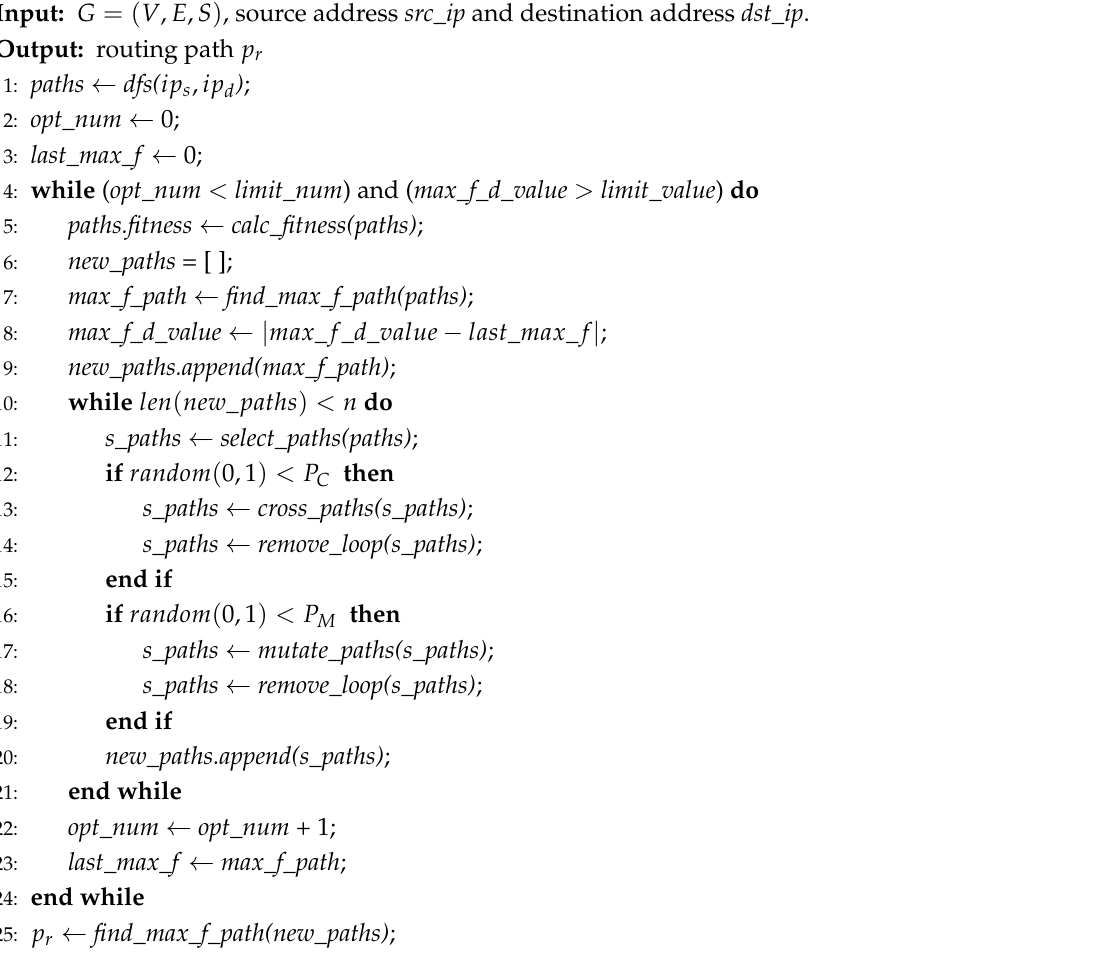
Algorithm 3 : Routing algorithm based on